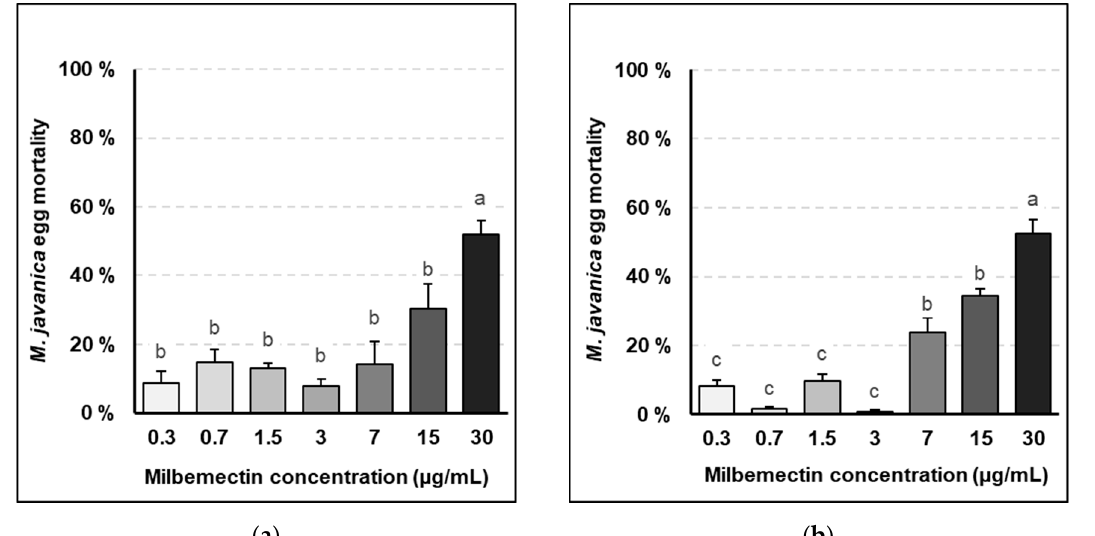
Figure 1. Meloidogyne javanica egg mortality due to progressively higher concentrations of pure milbemectin. ( a ) After 72-hour exposure; ( b ) after 240-h exposure to milbemectin. Data are mean of eight replicates. Error bars indicate the standard error of the means. Bars with the same letter do not differ significantly by the HSD Tukey test ( p < 0.05).